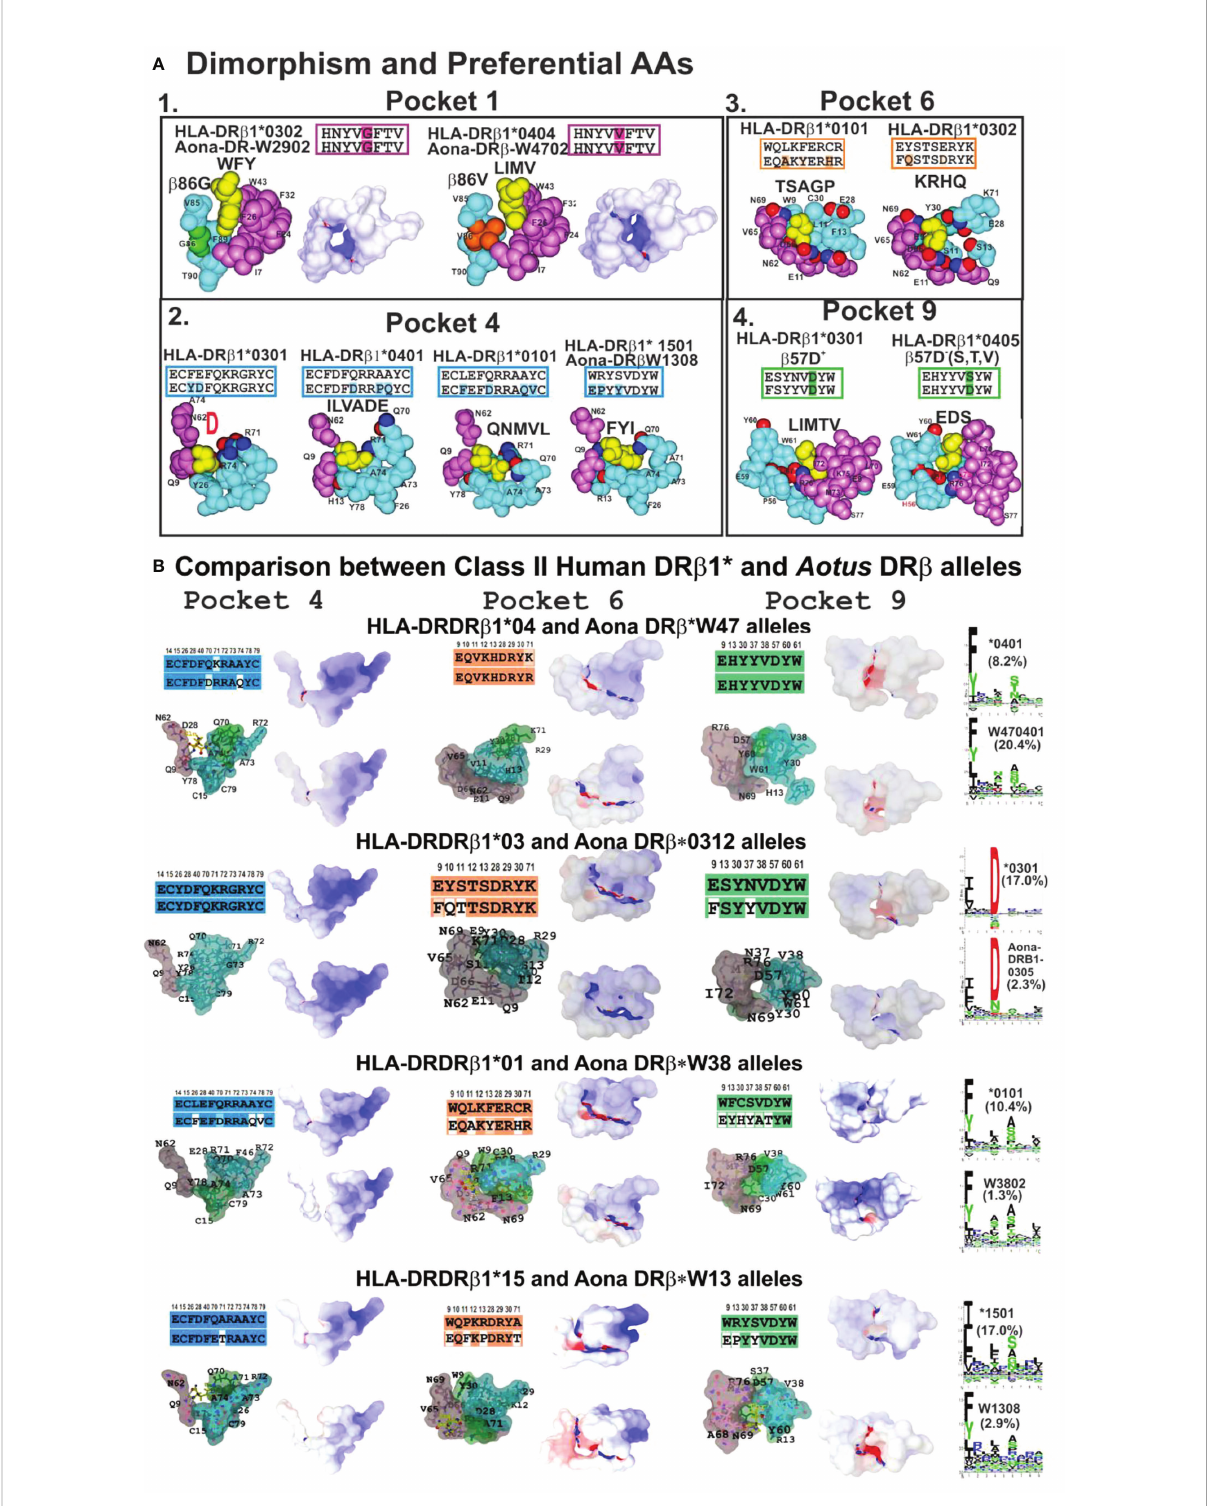
FIGURE 6 (A) P1 dimorphism and preferred aa for P4, P6 and P9, (A1, 2, 3, 4) showing the space required to fi t a peptide residue into each pocket. (B) Comparing class II human DR b 1* and Aona DR b allele structures in P4, P6 and P9 with their aa sequences (according to established colour code) and aa differences between these 2 species (uncoloured). Surfaces having electrostatic differences: electronegative (blue) and electropositive surfaces (red). Left-hand side: logos for each HLA-DR b 1* and Aotus DR allele; their frequency shown in parenthesis. Adapted from Ref.